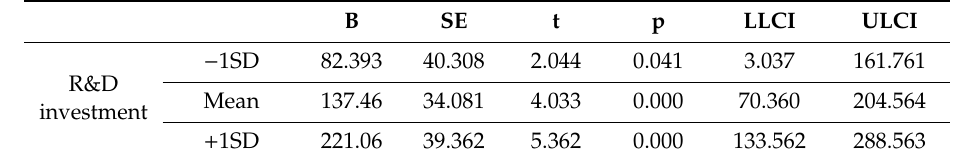
Table 4. Conditional e ff ect of R&D investment.